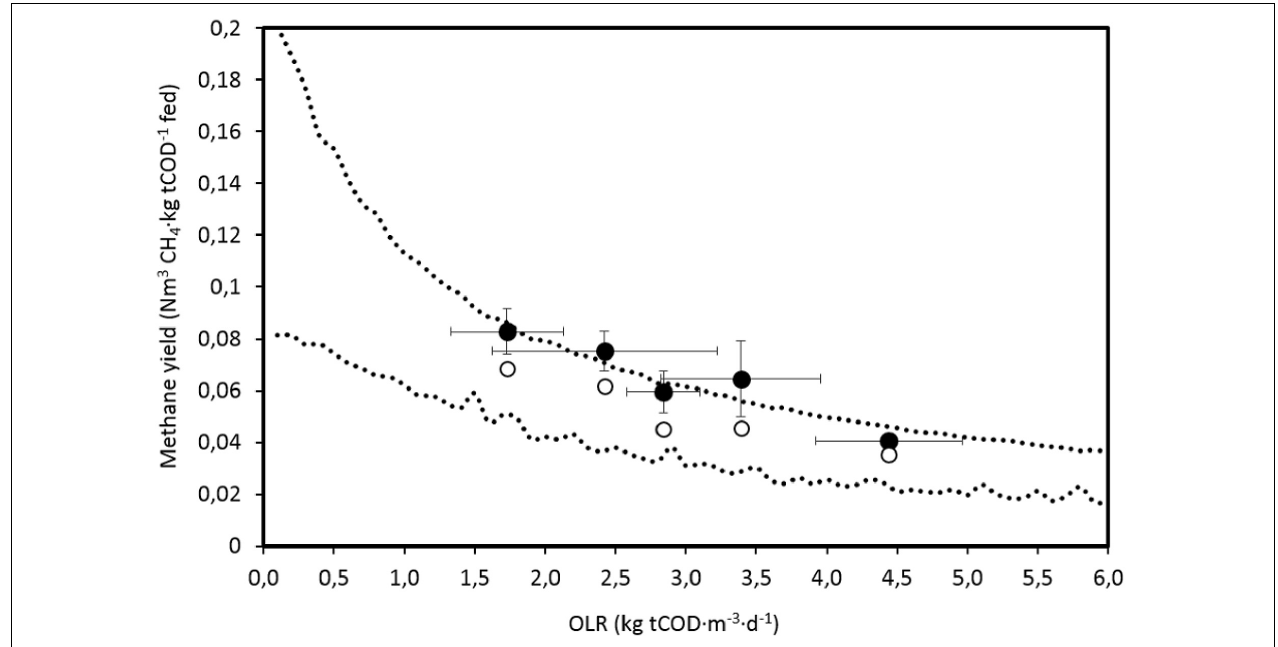
FIGURE 4 | Estimated 95% confidence interval by model 2, measured experimental values of the methane yield and estimated average values based on measured tCOD removal (0.35 Nm 3 CH 4 · kg COD − 1 removed), as a function of the organic loading rate (OLR). Error bars are standard deviations.